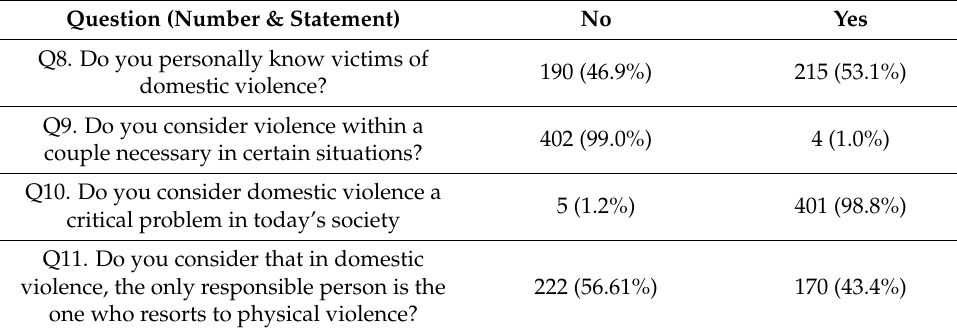
Table 2. The evaluation of the perception of the phenomenon.